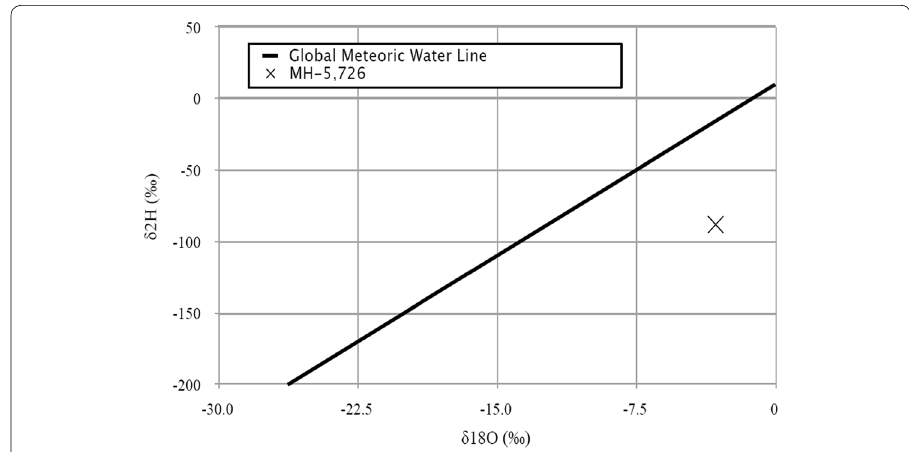
Fig. 3 Plot of deuterium and oxygen‑18 for MH‑2B sample in comparison to the